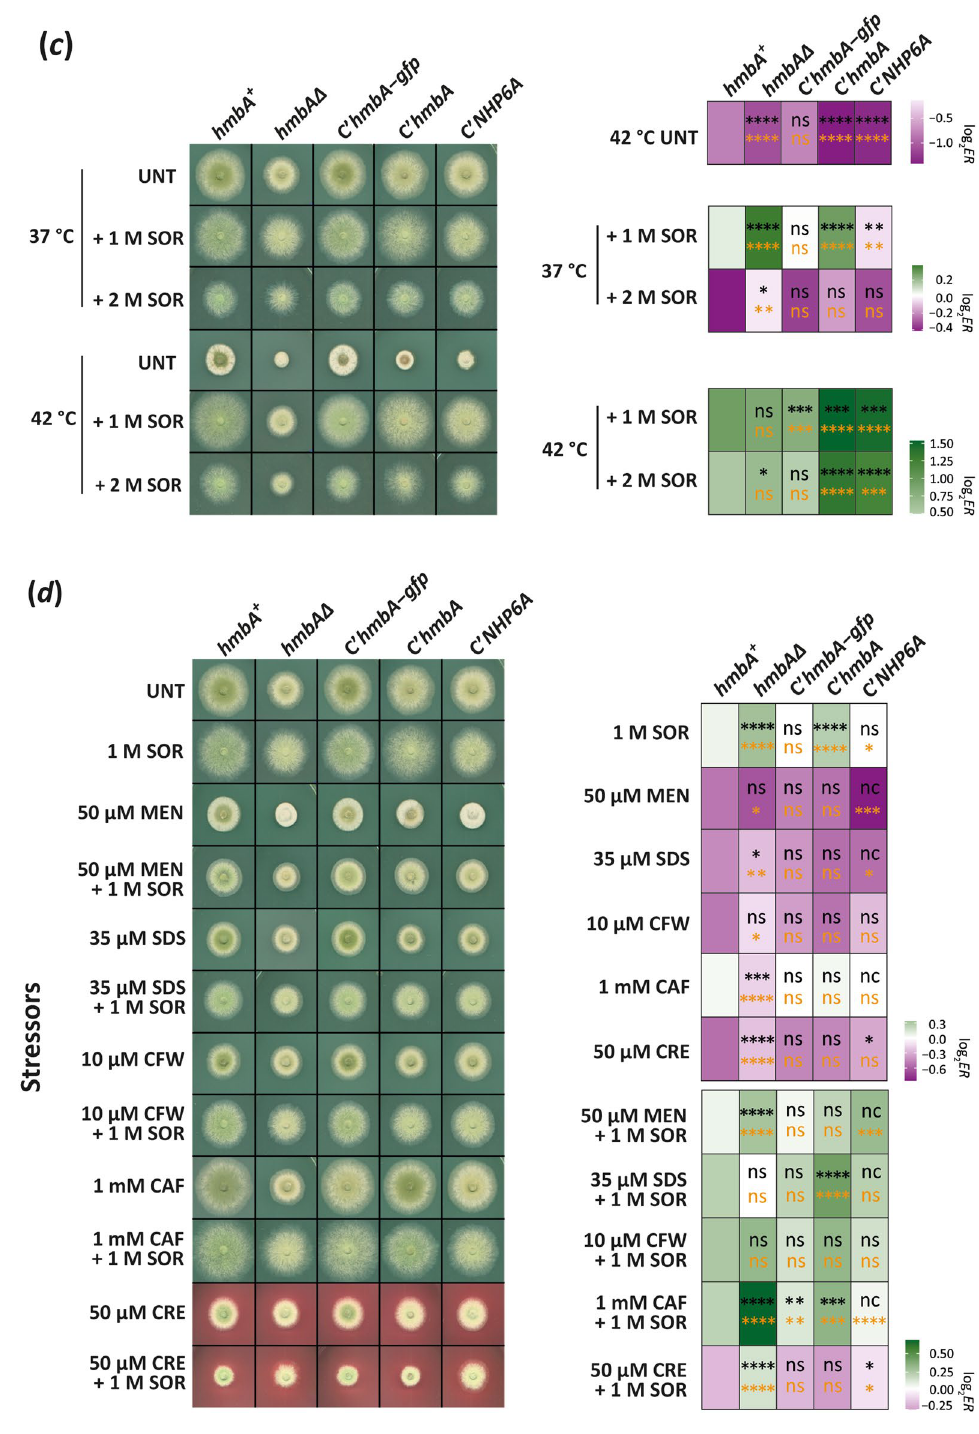
Figure 5. Fig. S1f). Cell wall disruptors (10 µM Calcofluor White, 50 µM Congo Red, 35 µM SDS) were better tolerated by hmbAΔ than by hmbA + (increased ER values, P < 0.05, P < 0.0001 and P < 0.01, respectively), however hmbAΔ was more sensitive to 1 mM caffeine than hmbA + (decreased ER value, P < 0.0001) (Fig. 5d, Supplementary Fig. S1f). The differential responses of hmbAΔ and hmbA + in the presence of cell wall disruptors might reflect strain- specific differences in the cell wall architecture. The supplementation of the media with 1 M sorbitol resulted in an increased ER value in all tested strains (Fig. 5d, Supplementary Fig. S1f). Response to the presence of a heavy metal stressor (50 µM cadmium sulphate) in hmbAΔ was similar to that of hmbA + and the C’ hmbA and C’ hmbA-gfp complemented strains (Supplementary Fig. S1f). Notably, the C’ NHP6A